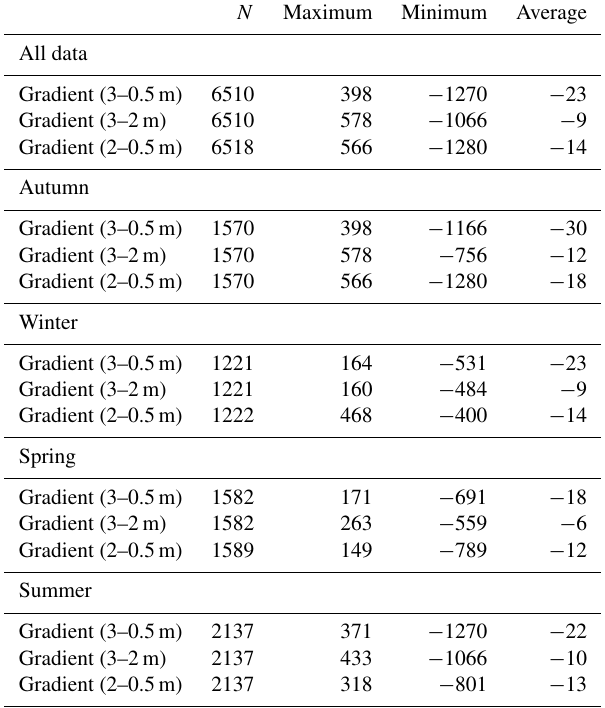
Table 2. Statistical summary of gradients: total gradient (3–0.5m), upper gradient (3–2m) and lower gradient (2–0.5m). All TGM data are in nanograms per cubic metre (ngm − 3